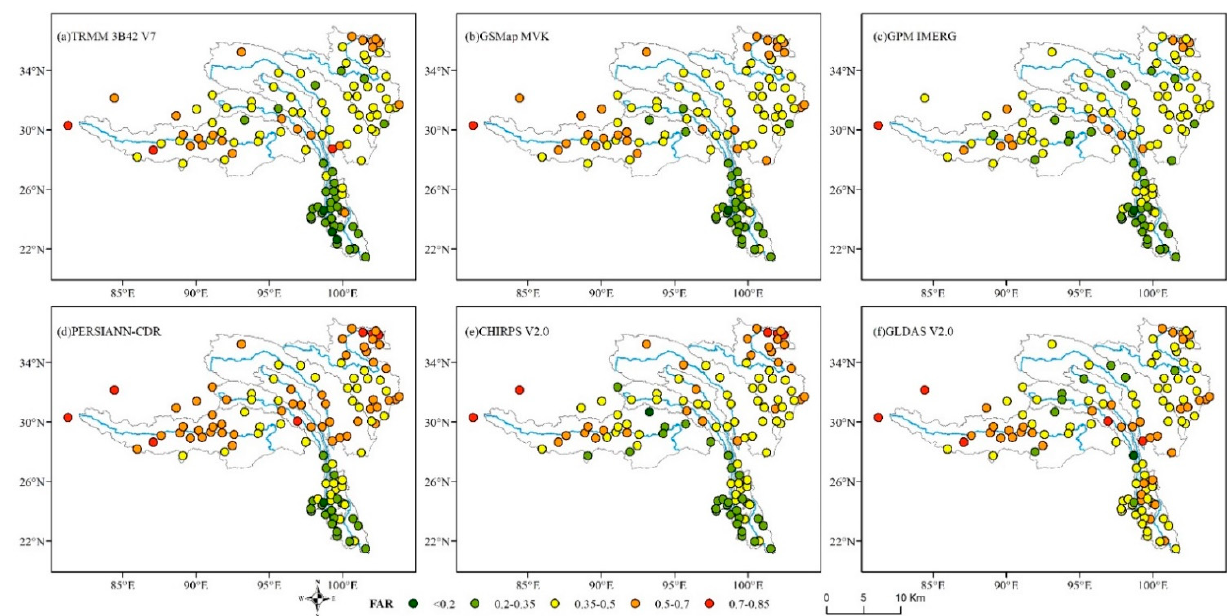
Figure 10. The FAR between different rain gauges and corresponding grids in data products.